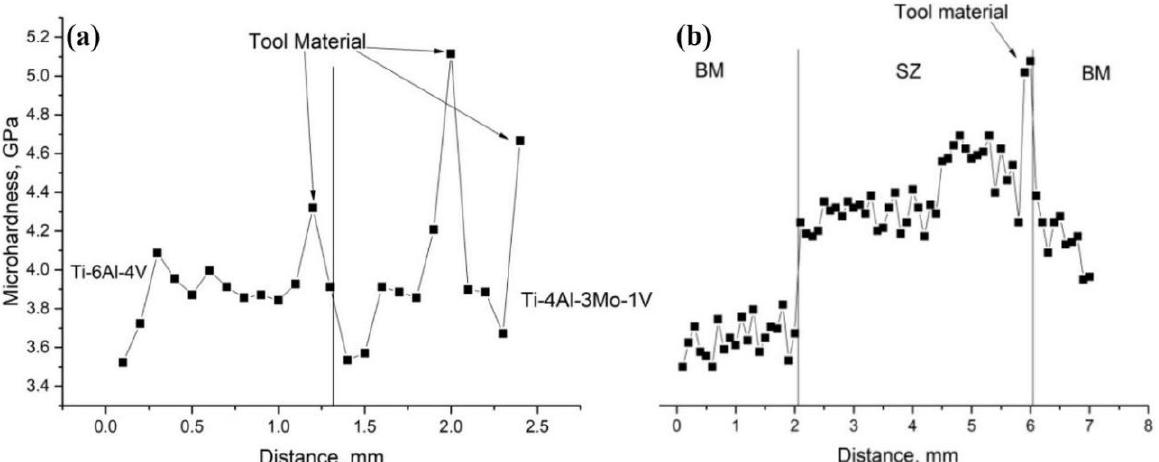
Figure 16. Microhardness of the welded joint Ti-6Al-4V and Ti-4Al-3Mo-1V alloys obtained by fric- tion stir welding in a vertical direction ( a ), and obtained by friction stir welding in a vertical direc- tion ( b ).